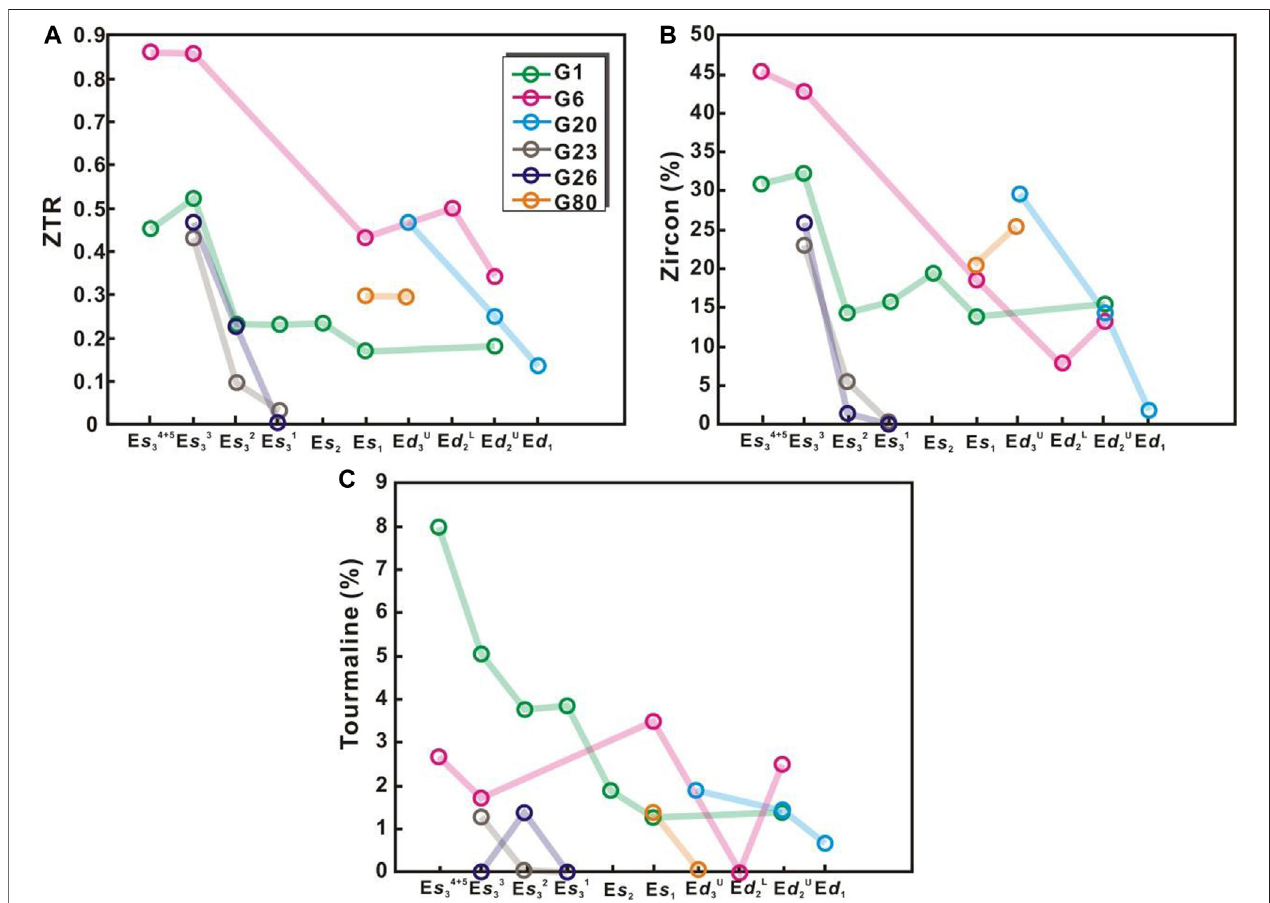
FIGURE 10 | Active characteristics of the Xinanzhuang Fault in different